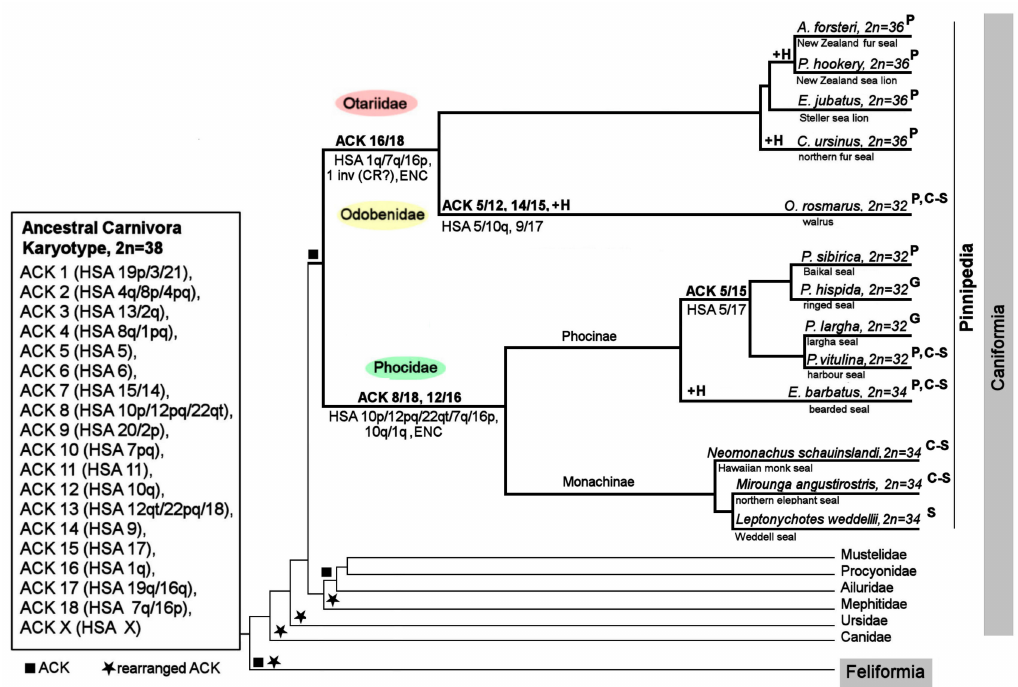
Figure 9. A compiled scheme of karyotype evolution in Pinnipedia, including the species studied here and species for which whole-genome sequencing data are available. The fusion of ancestral elements is designated by “ / ”. + H: heterochromatin addition, ENC: evolutionarily new centromere, inv (CR?): inversion or centromere repositioning. G G-banding only, P painting data, S whole-genome sequencing data, and C-S chromosome level genome assembly (C-Sca ff olds) [19,68]. The cytogenetic data are consistent with the tree topology based on published Carnivora phylogenies a ffi rming pinniped monophyly [69]. The basal position of the walrus is supported by two extra fusion events [70]. The lineage of the northern fur seal first split from Otariidae ~8 mya [71,72]. The separation of the bearded seal ~12 mya from the rest of Phocinae [70] is confirmed here. Substantial enrichment with repeated sequences with variation of nucleotide composition has occurred during long-term monotypic evolution in O. rosmarus , C. ursinus , and E. barbatus in contrast to fewer heterochromatin changes in evolutionarily recent pinniped species. Cytogenetically, Phoca and Pusa and likely other genera with 2n = 32 on this branch are linked by a single fusion (ACK 5 / 15). Overall, pinniped karyotype evolution has had a slow rate of genome rearrangements with less than one rearrangement per 10 million years